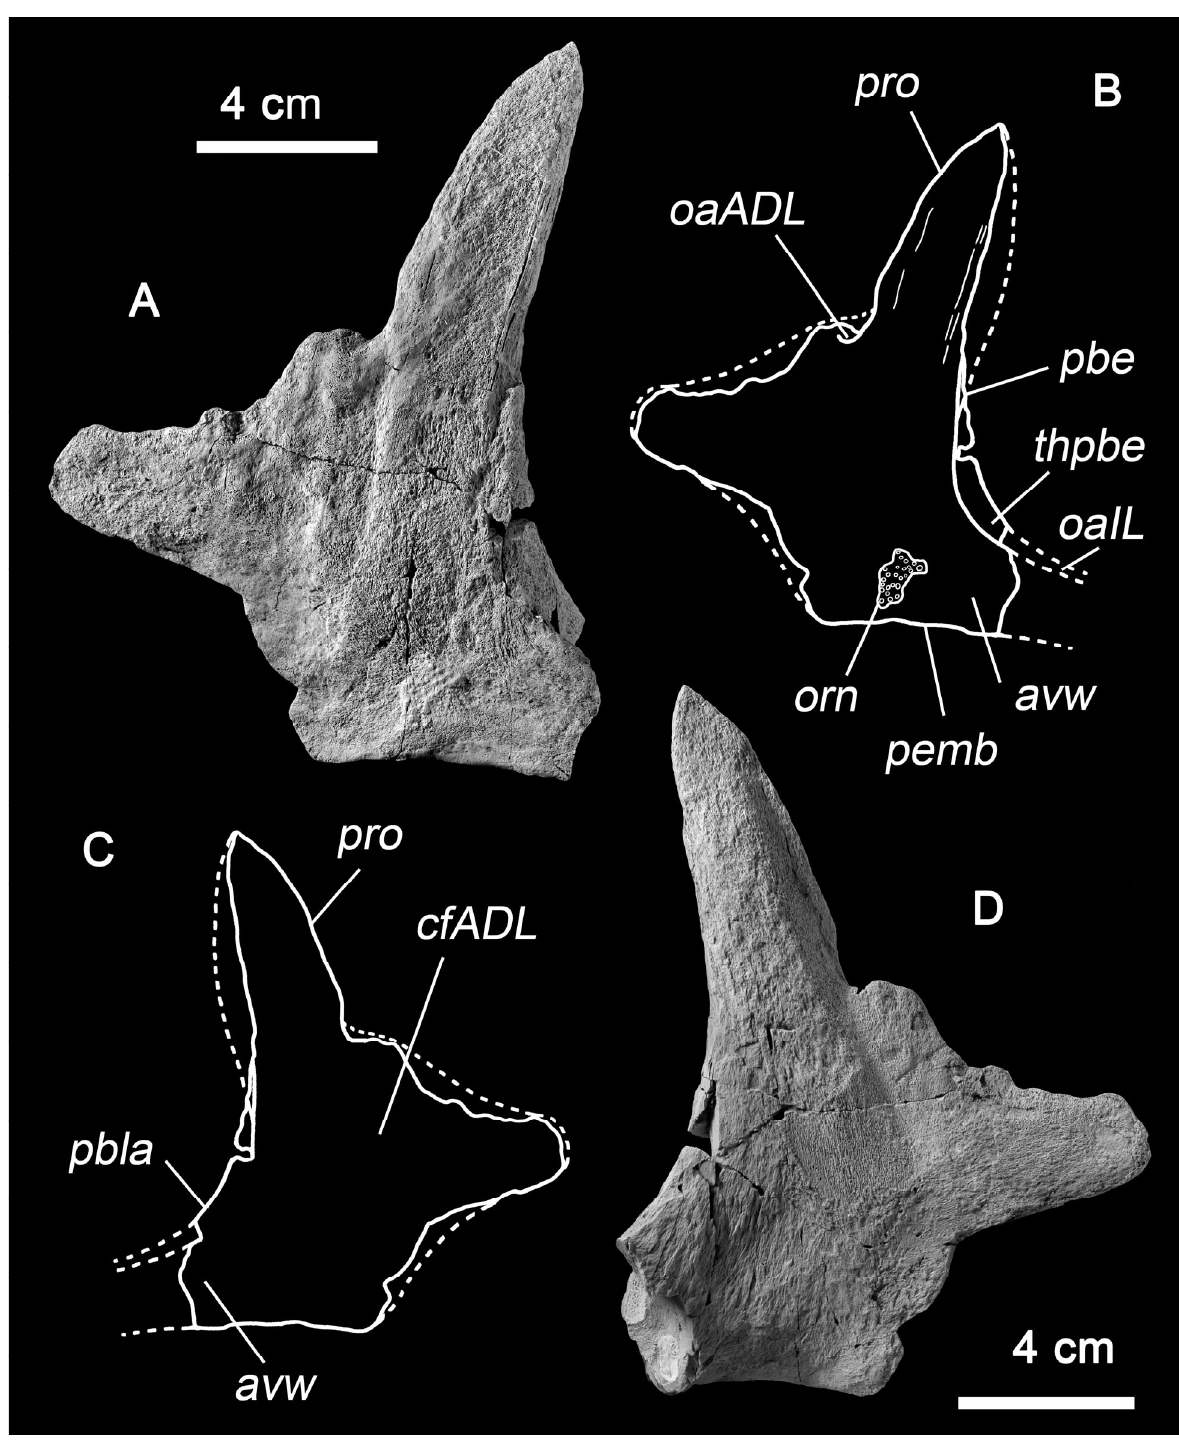
Fig. 4. ?Dunkleosteidae gen. et sp. indet., PIN 2921/3269, anterolateral plate of the thoracic armour (AL). Lipetsk Region, Central Russia, right bank of the Rykhotka River (right tributary of the Don River), a local quarry approximately 100 m north of the Voskresenskoye village. A , lateral view; B , interpretative drawing of the lateral view; C , interpretative drawing of the visceral view; D , visceral view. Abbreviations: avw , anteroventral process; cfADL , contact face for the anterior dorsolateral plate; oaADL , overlap surface for the anterior dorsolateral plate; oaIL , reconstructed position of the overlap surface for the interlateral plate; orn , an area showing preserved dermal sculpturing; pbe , postbranchial embayment; pbla , postbranchial lamina; pemb , the margin adjoining the pectoral fin; pro , obstentic process; thpbe , postbranchial thickening of the anteroventral